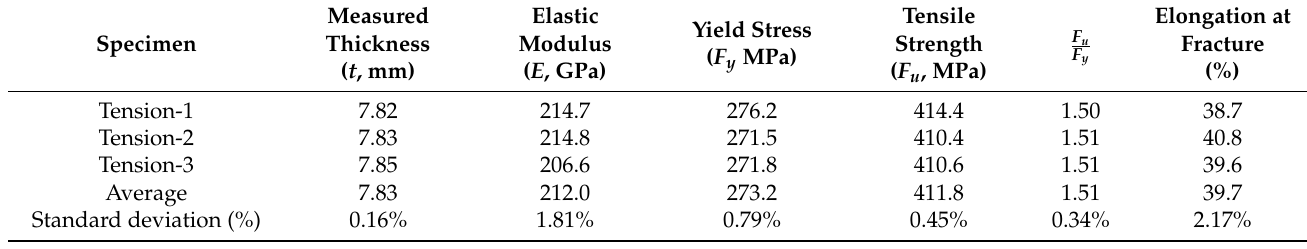
Table 1. Material properties of SS275 steel from tension coupon specimens.